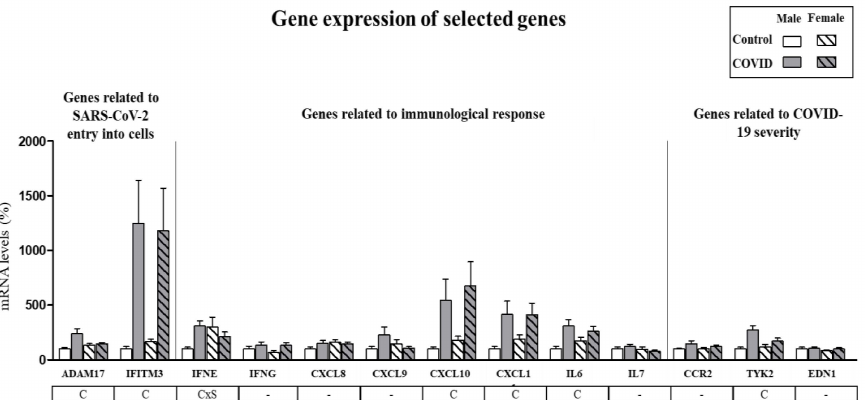
Figure 1. Expression levels of selected genes in PBCs in male and female control subjects and COVID- 19 patients. mRNA levels were measured by real-time qPCR and expressed as a percentage of the value of control males. Data are expressed as the mean ± SEM of 15–43 samples per group. Statistics: C, effect of COVID; CxS, interaction between COVID and sex ( p < 0.05, two-way